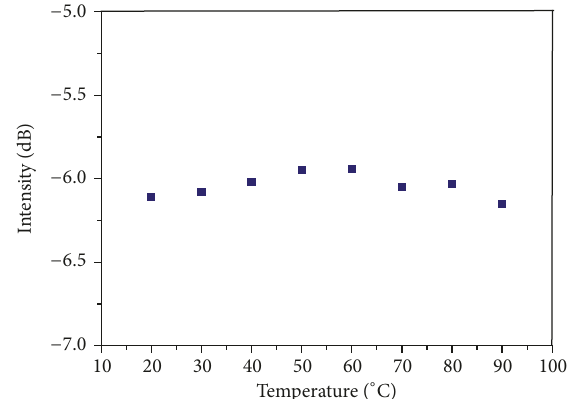
Figure 9: The variation of temperature and wavelength in the external